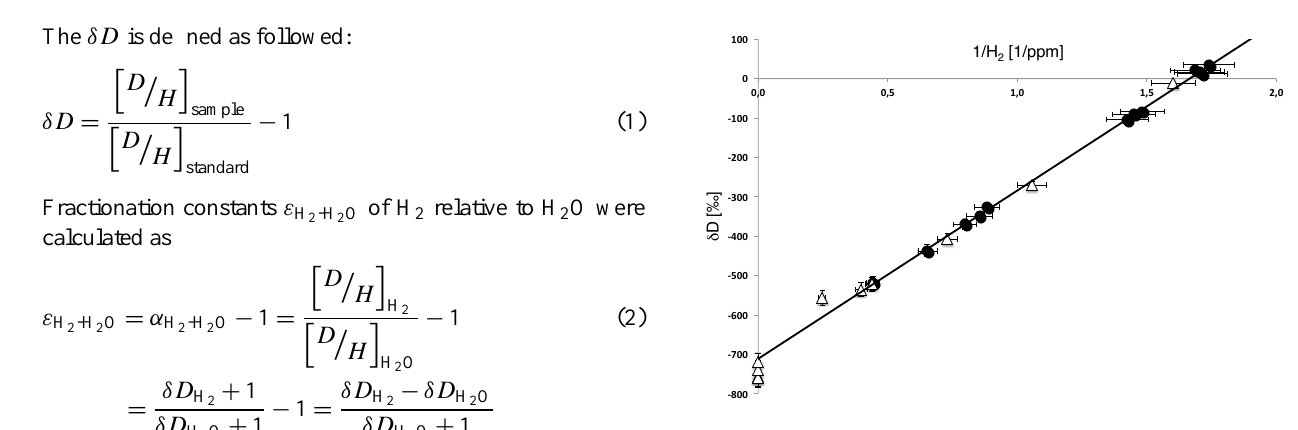
Fig. 1. Keeling plot of the diluted samples from the biogas reactor at 38 ◦ C (black dots, excluding the inoculum). The least-square fit result is y = 427 . 4 x − 711 . 55, R 2 = 0 . 999. For completeness the results of the treatments at different temperatures, of the inoculum and the pure cultures are also included in the figure (triangles), but not taken into account for determination of the source